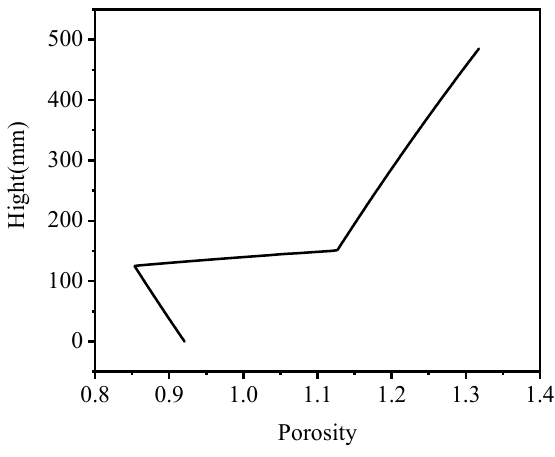
Figure 16. Void ratio along